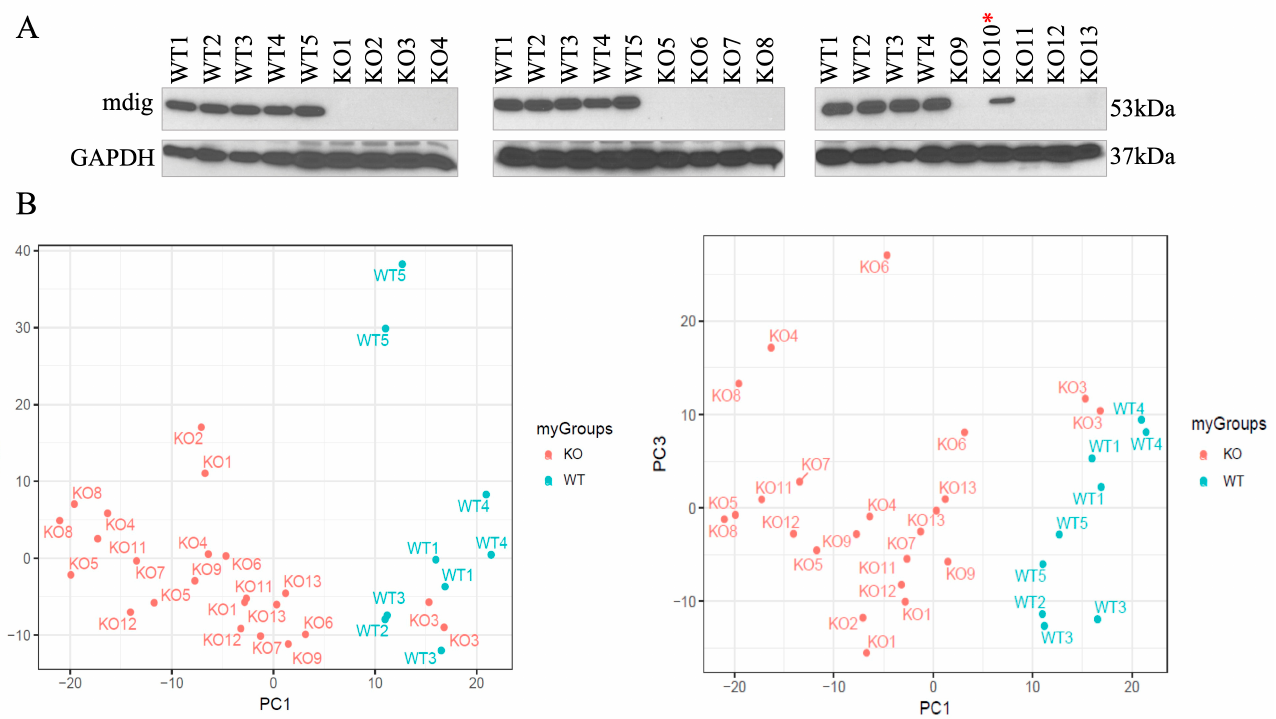
Figure 1. Establishment of mdig knockout cells by CRISPR-Cas9 gene editing. ( A ), Validation of mdig depletion by CRISPR-Cas9 gene editing through Western blotting for mdig . WT cells represent cells subjected to gene editing but mdig gene remains intact, whereas KO cells represent successful knockout of mdig by gene editing. A total of 5 WT and 13 KO clones are shown. GAPDH was used as a loading control. Asterisks (*) indicates the KO clone containing residual mdig protein. ( B ), All the WT and KO colonies in duplicates were subjected to proteomics assay. Principal component analysis of the colonies indicated some within group heterogeneity. The colonies were validated and were proceeded for downstream data analysis. KO#10, KO#3, and WT#5 were excluded from further